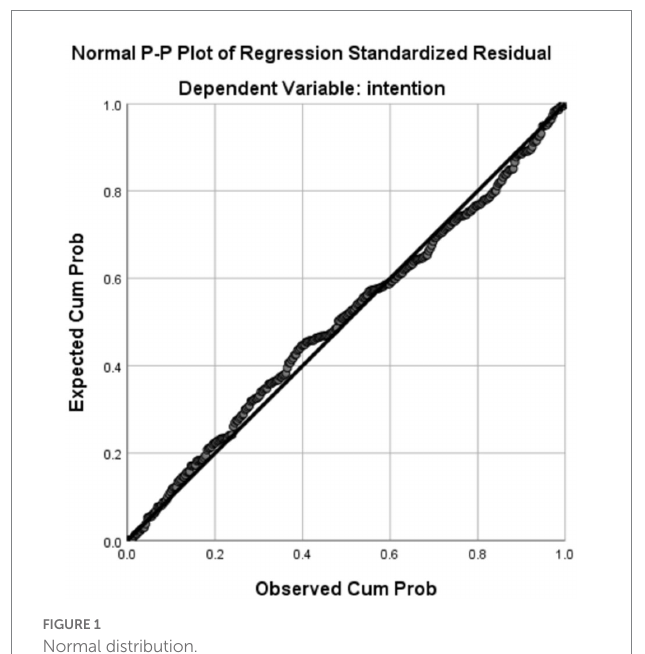
FIGURE 1 Normal